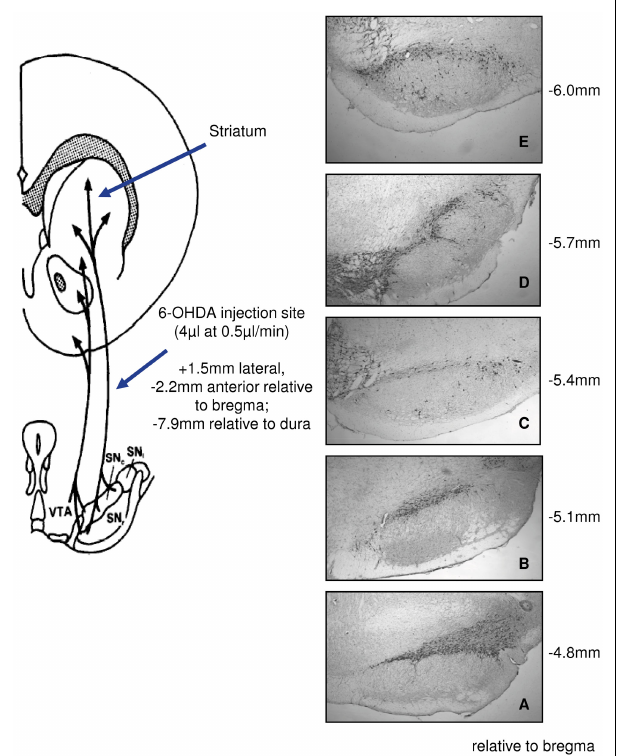
FIGURE 1 | Experimental Parkinson’s disease created by unilateral infusions of 6-hydroxydopamine (6-OHDA). Schematic representation of placement of the lesions, under general anesthesia, into the left medial forebrain bundle (left panel) and immunocytochemical detection 1–2weeks later of tyrosine hydroxylase, the rate-limiting enzyme in dopamine synthesis, to identify dopaminergic neurons through five levels (A–E) of the substantia nigra pars compacta (right